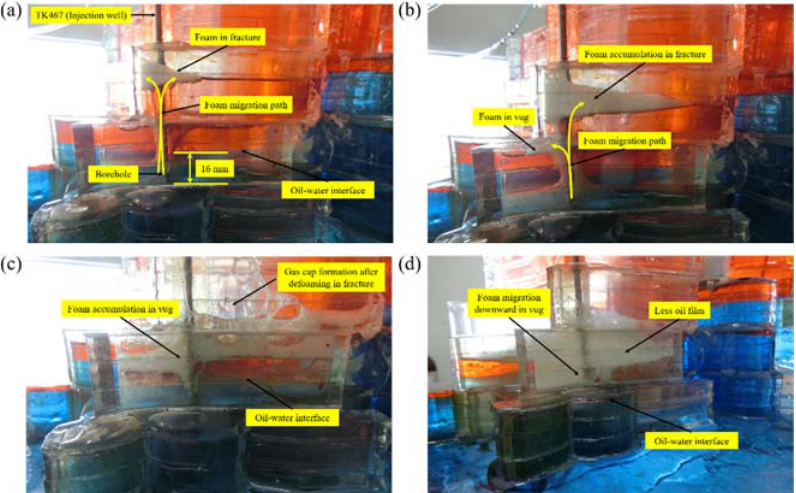
Figure 3. Foam flow characteristics around the injection well TK467: ( a ) Early stage of foam migration, ( b ) Accumulation of foam, ( c ) Formation of N 2 cap, ( d ) Detachment of oil film. A graph depicting the evolution of the OWI position around the well TK467 with time is plotted in Figure 4. The slope of this curve represents the moving rate of the OWI. The injected foam accumulates in the fracture–vuggy unit’s top controlled by TK467 and then acts on the residual attic oil, leading to the OWI’s height decrease. The decline rate of the OWI height keeps stable at 0.0357 mm/s until the OWI decreases to the cylinder base tank.